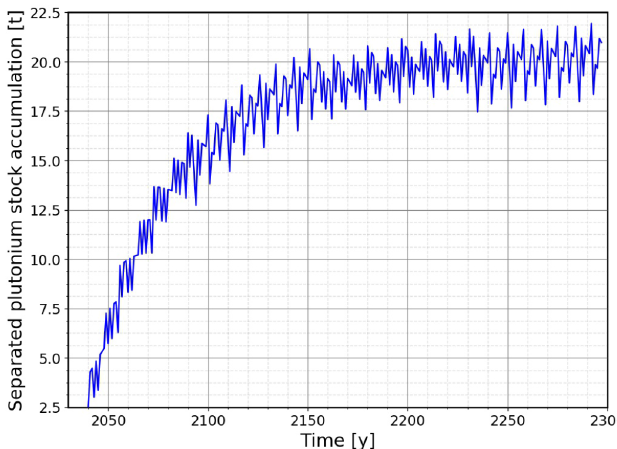
Fig. 5. COSI6 UOX - MOX Pu stock accumulation.